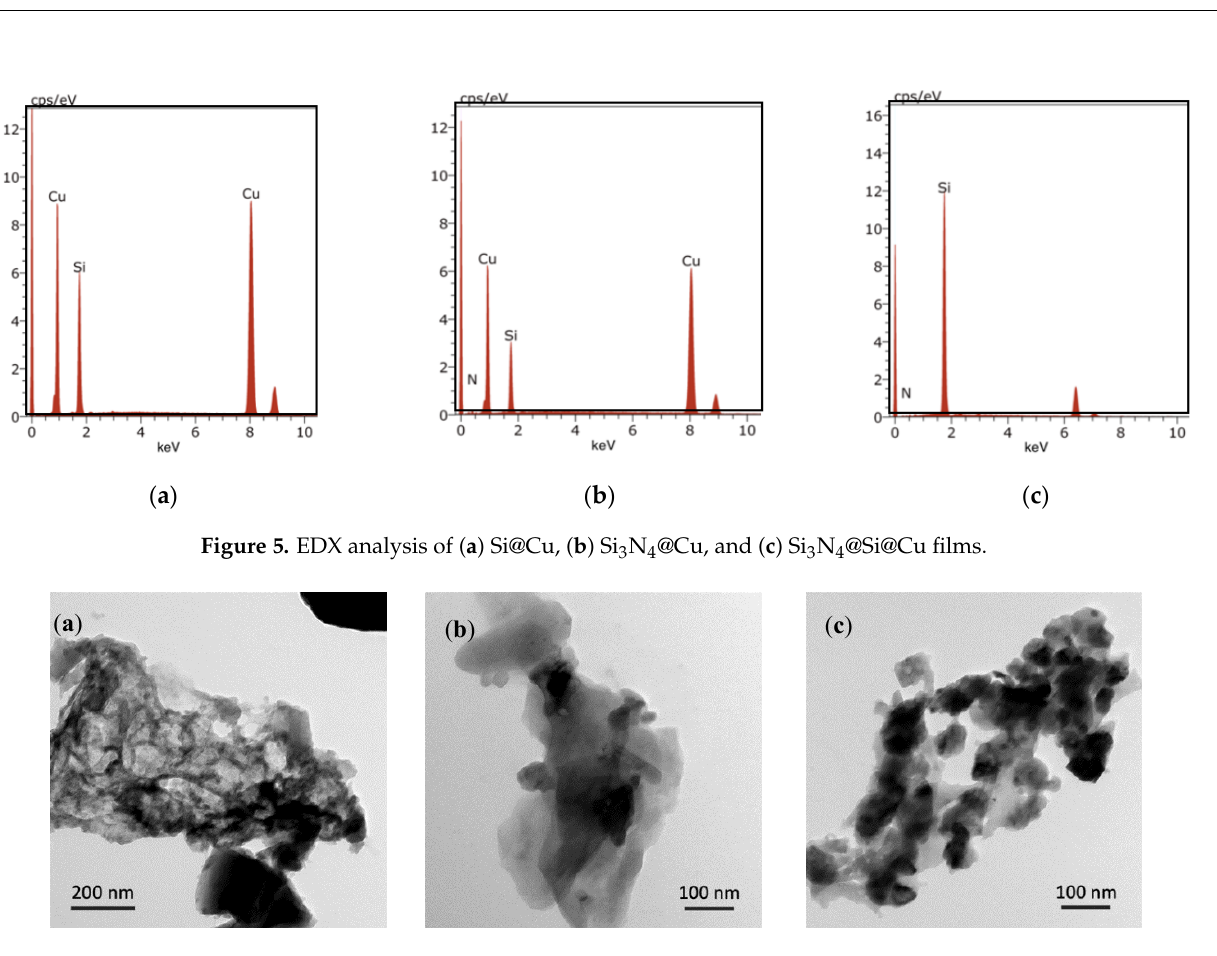
Figure 6. TEM images of ( a ) Si@Cu, ( b ) Si 3 N 4 @Cu, and ( c ) Si 3 N 4 @Si@Cu prepared by RF sputtering.